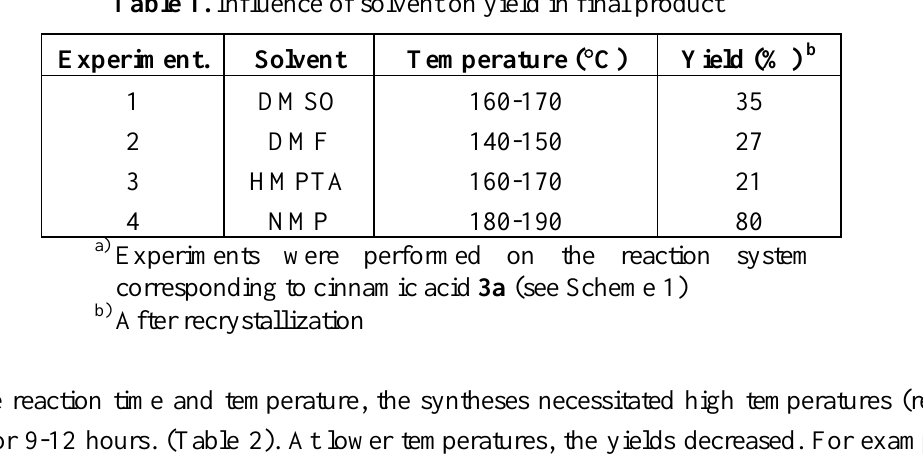
Table 1. Influence of solvent on yield in final product